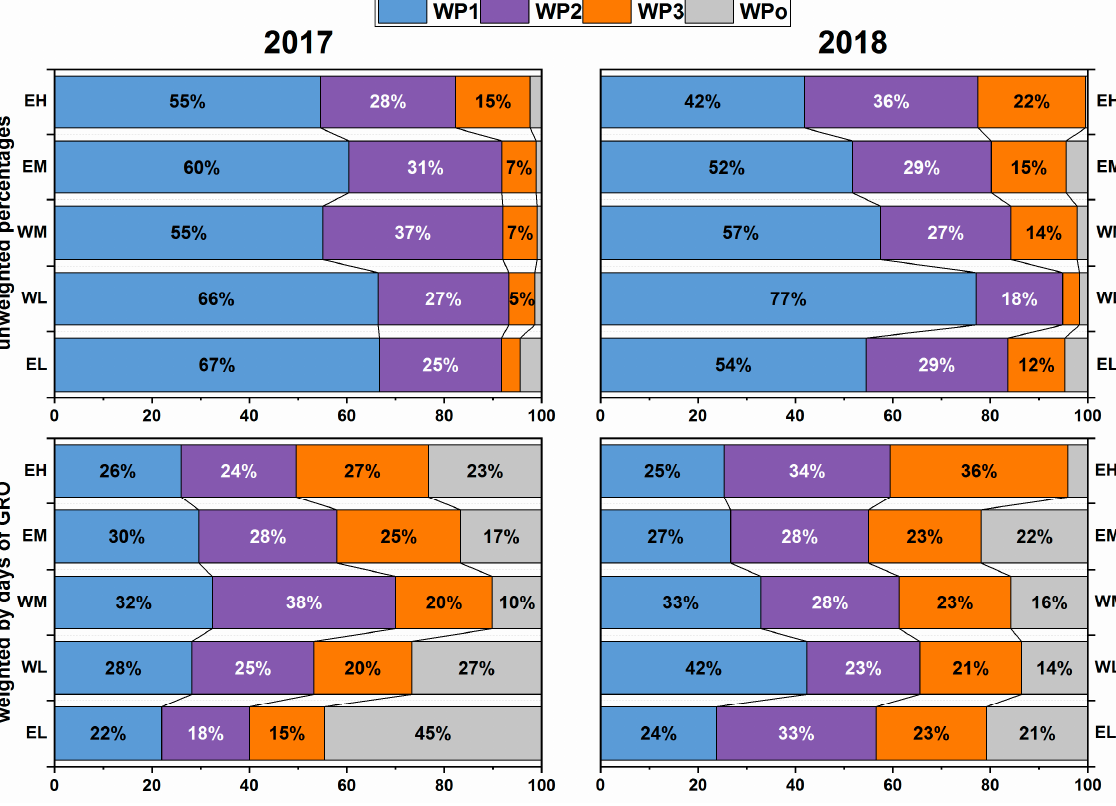
Figure 6. Comparison of percentages of GRO that occurred during the respective weather patterns in 2017 and 2018. Other weather patterns (WPo) represent the rarely occurring other weather patterns (4, 5, and 6) described in Knerr et al. [41]. Upper panels show percentages of total GRO amount, and lower panels represent the same data weighted by days of the occurrence of GRO.